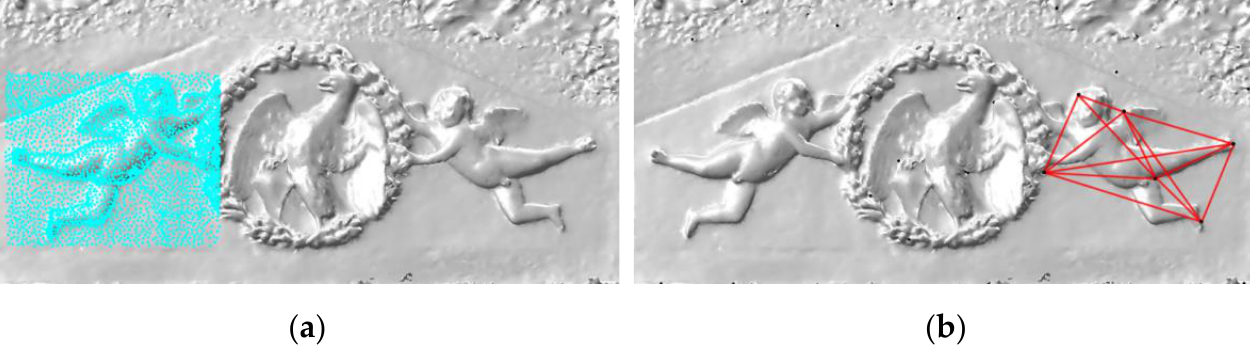
Figure 8. Illustration of a matching distance descriptor calculated using quantization level 𝑘 = 3 for the sample area quantization and corresponding 14 × 42 × 12 number of the whole mesh quantization. ( a ) Set of vertices selected in the sample area, ( b ) matched area with calculated dis- tance descriptors.